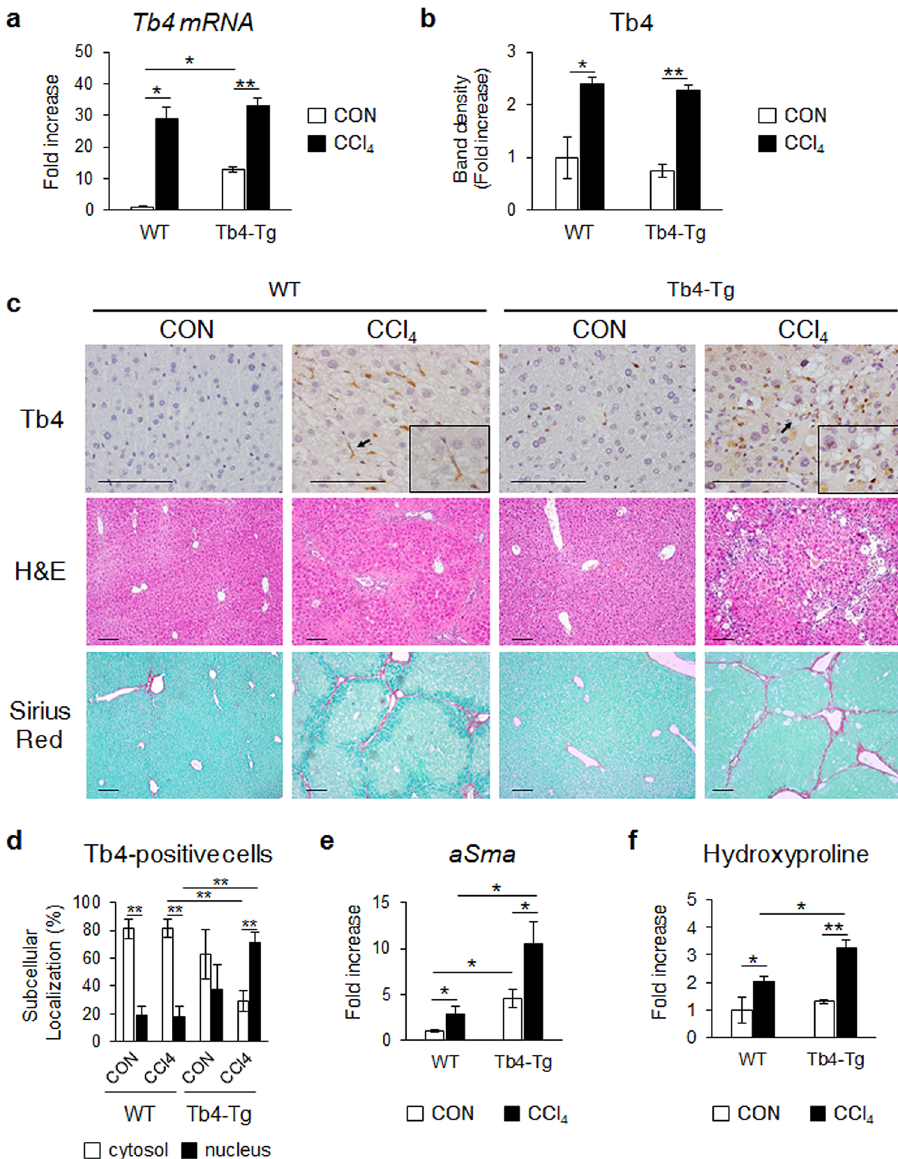
Figure 7. Severe hepatic fibrosis in Tb4 overexpressing transgenic mice. ( a ) qRT-PCR for Tb4 in livers from wild-type (WT) and Tb4 overexpressing transgenic (Tb4-Tg) mice injected with corn-oil (CON) or carbon tetrachloride (CCl 4 ) for 10 weeks (n = 4 mice/group). ( b ) Cumulative densitometric analyses of Tb4 western blot results. ( c ) Representative images of immunostaining for Tb4 ( × 40), hematoxylin and eosin (H&E) staining ( × 20) and sirius red staining ( × 20) in liver sections from representative WT and Tb4-Tg mice with CON or CCl 4. (scale bar, 100 μ m) ( d ) Quantification of nuclear or cytoplasmic Tb4-postive cells in all mice. The number of nuclear or cytosolic Tb4-positive cells were counted in parenchymal area/section ( ** Nuclear localization p < 0.005). ( e ) RNA expression of aSma in livers from all mice. ( f ) Hepatic hydroxyproline contents in liver of all mice. All results are displayed as mean ± s.e.m. (n = 4 mice/group) ( * p < 0.05; ** p <